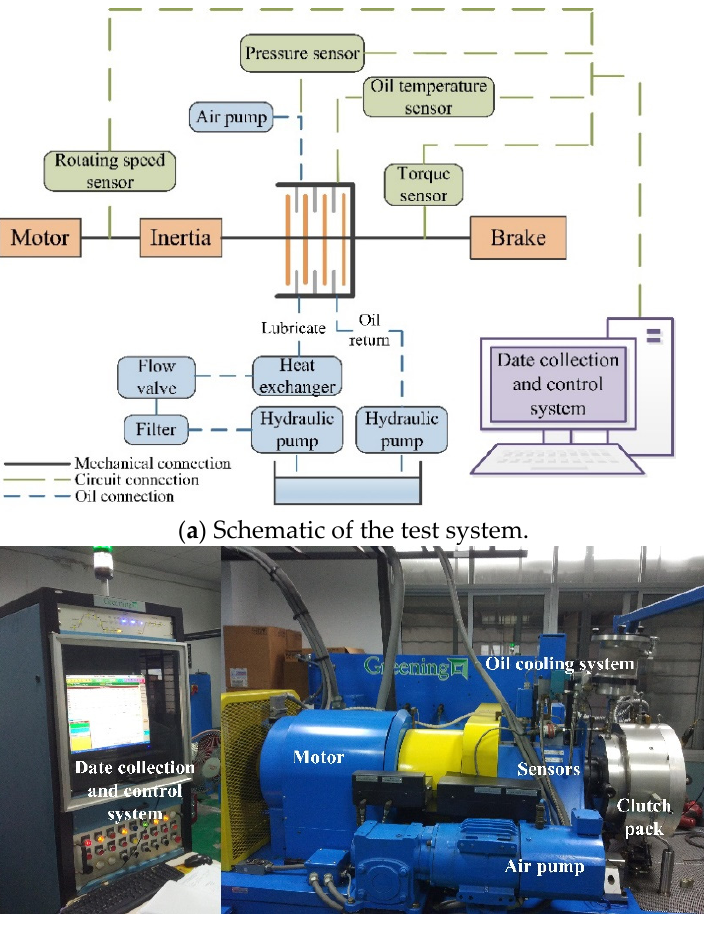
Figure 9. Test system of the multidisc clutch.